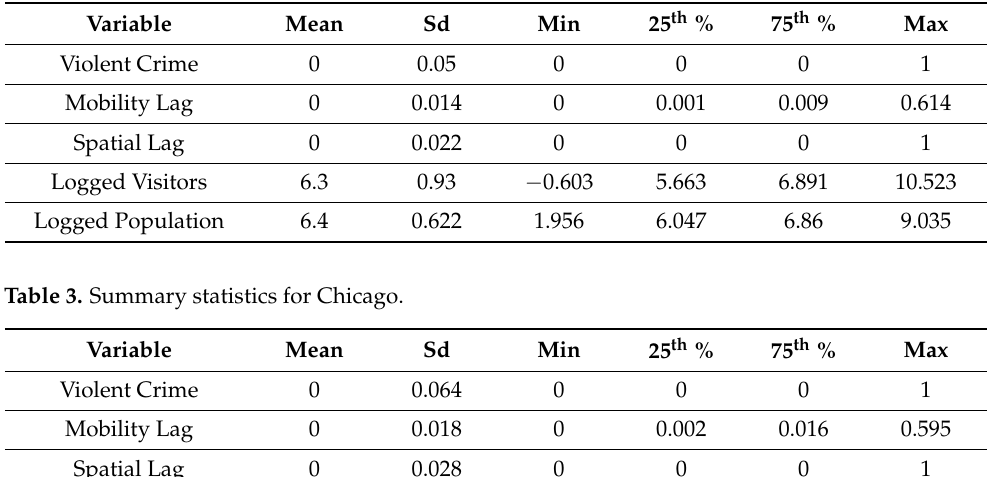
Table 2. Summary statistics for Los Angeles.